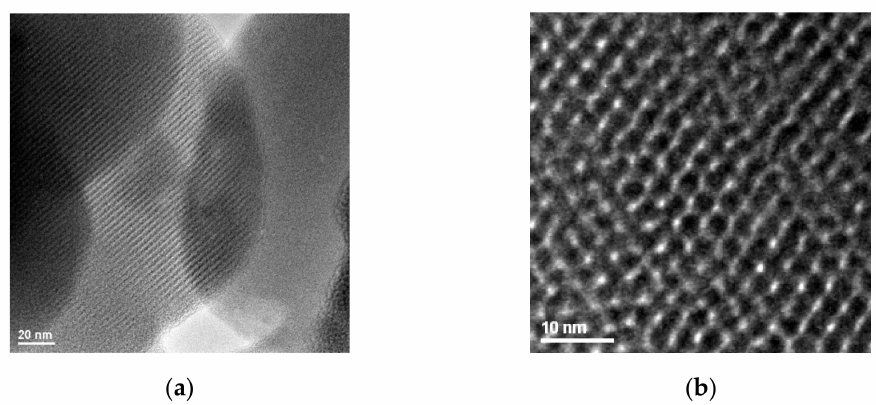
Figure 3. Representative HR-TEM images of non-functionalized MCM-41 material for 20 nm ( a ) and MCM-41/APS for 10 nm ( b ) scale bars.